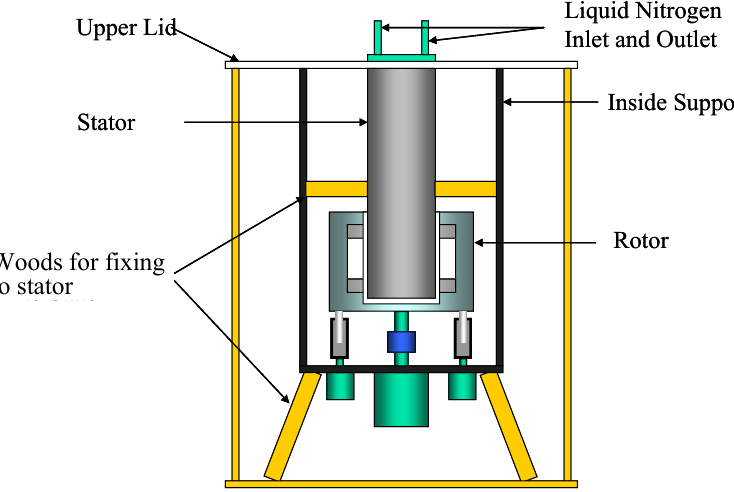
Figure 10. Schematic illustration of the flywheel energy storage system in the case of a fixed stator. Figure 11 shows the free-run experimental results in the case of a fixed stator, representing (a) a natural rotation decay curve, (b) displacement at an upper position of the rotor and (c) displacement at a lower position of the rotor. The results in the case of the fixed stator in Figure 11 correspond to the results in Figure 6. In Figure 6, the resonance rotation speeds at ≈ 300 rpm and ≈ 800 rpm are shown. However, there is no resonance rotation speed in Figure 11, as the stator is fixed to the ground base. In the case of making such types of suspended systems, it is important to fix the stator to the base ground.